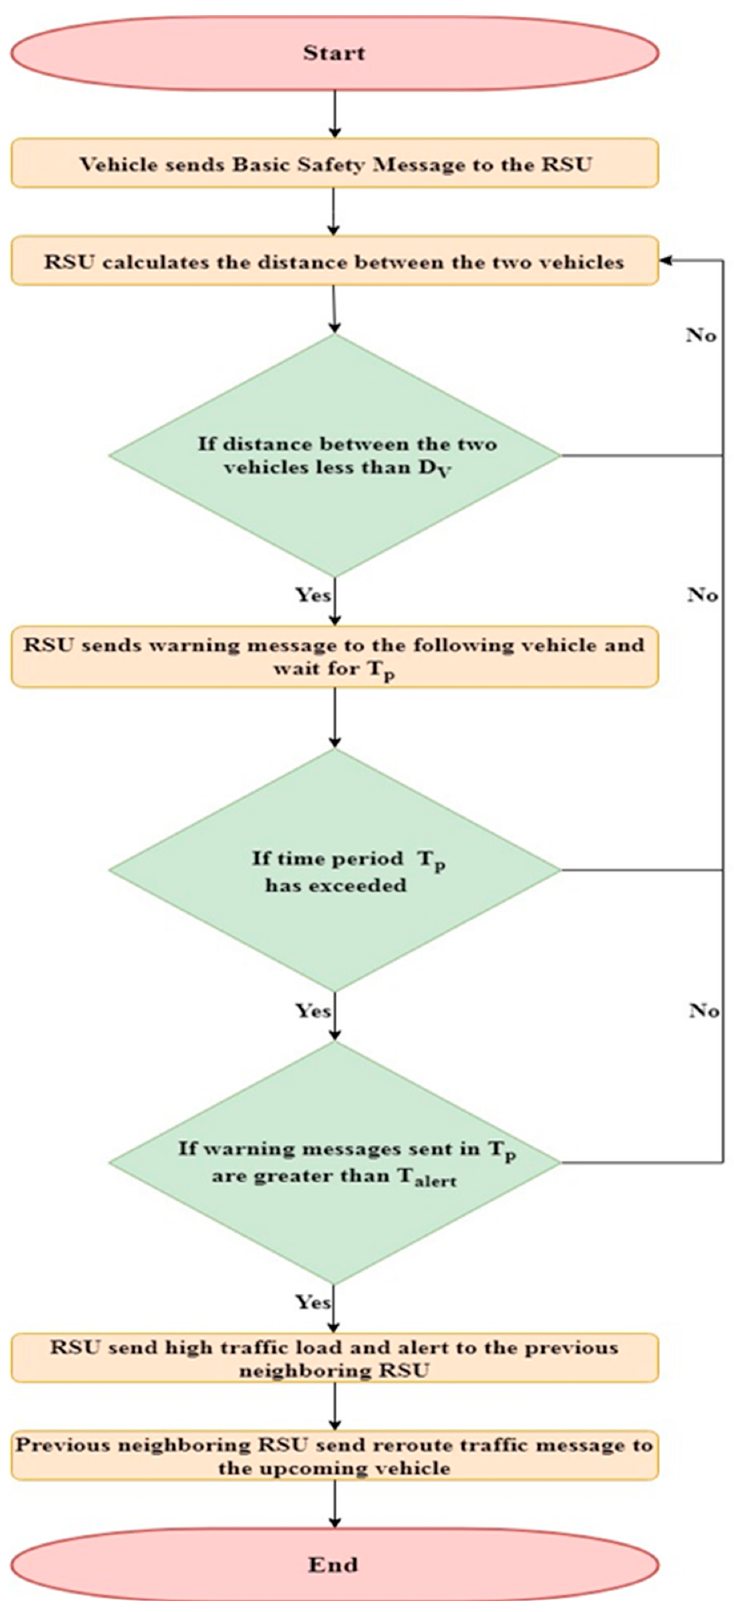
Figure 4. Workflow of TARS.